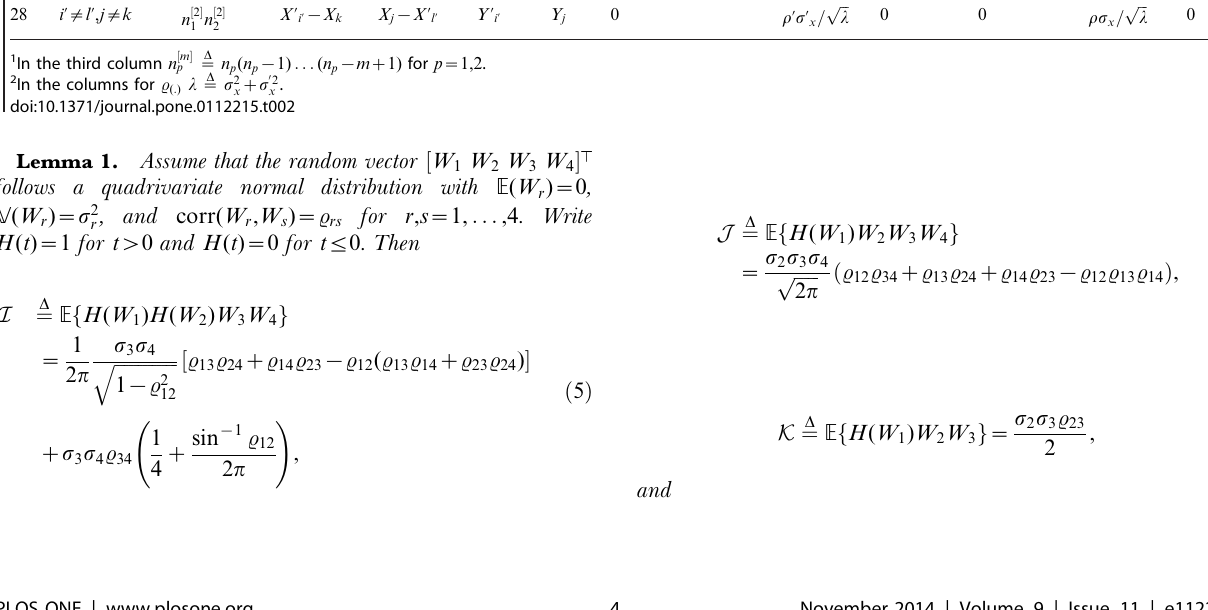
Table 2. Quantities for Evaluating A ~ P n